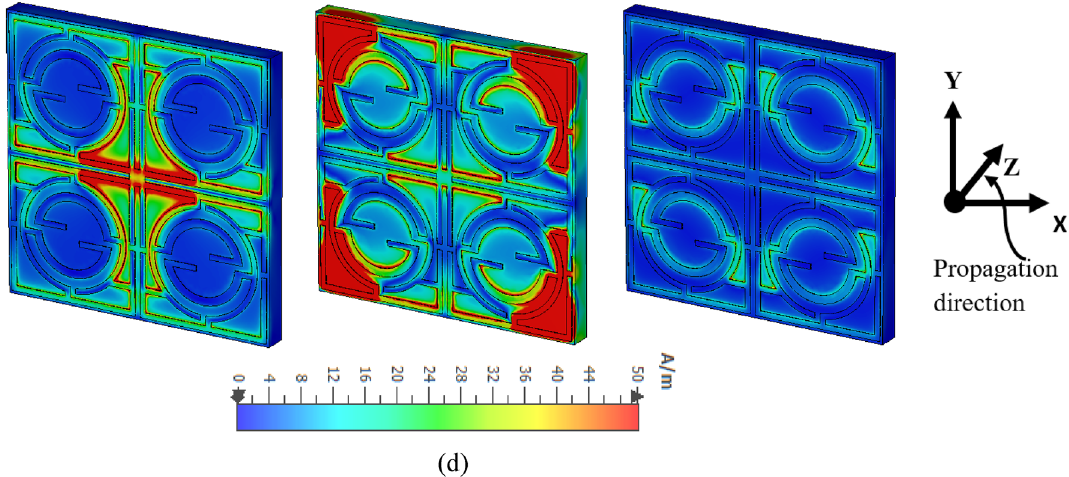
Figure 11. Magnetic (H) field distribution on MTM: ( a ) 1.98 GHz, ( b ) 4.74 GHz, ( c ) 8.34 GHz, ( d ) scale with color coded bar for the magnitude of H field ( CST microwave studio suite 2019).